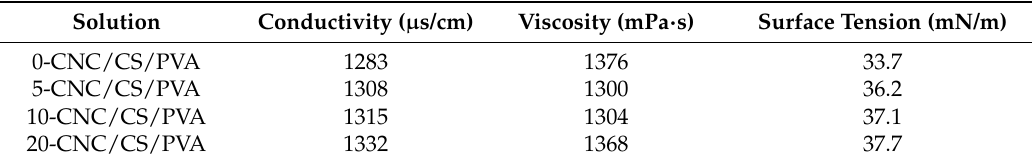
Figure 2. Optical microscopy images of mixed solution with different CNC loading level: ( a ) 0 wt %; ( b ) 5 wt %; ( c ) 10 wt %; and ( d ) 20 wt %. The inset images represent the photograph of spinning solutions with various CNC contents. Table 1. Properties of as-spun